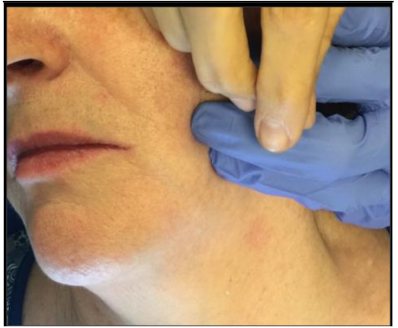
Figure 1. Patient lying in the required position for